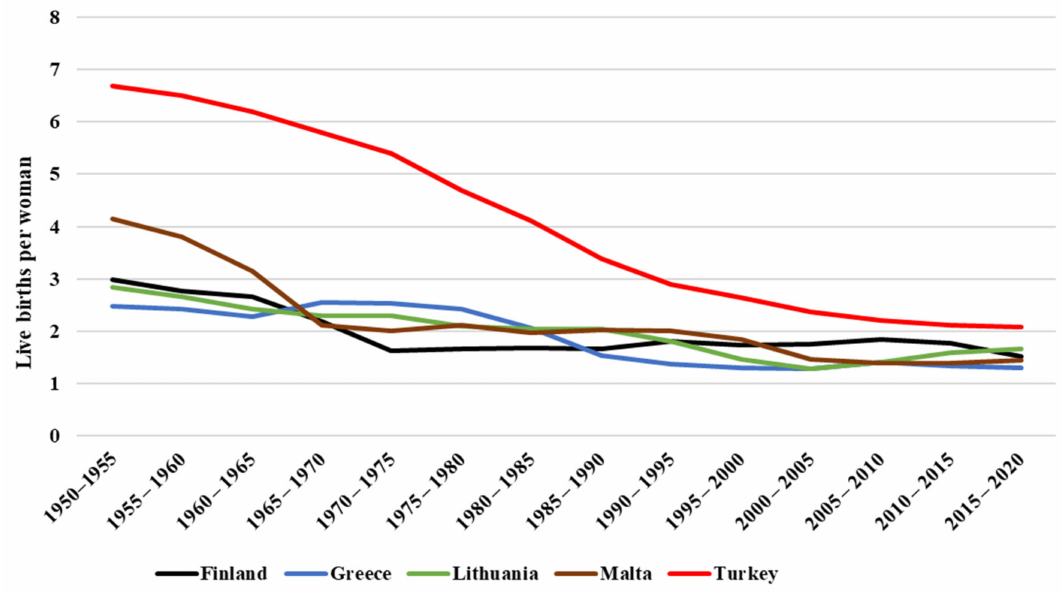
Figure 2. Total fertility 1950–2020 (live births per woman). Source: